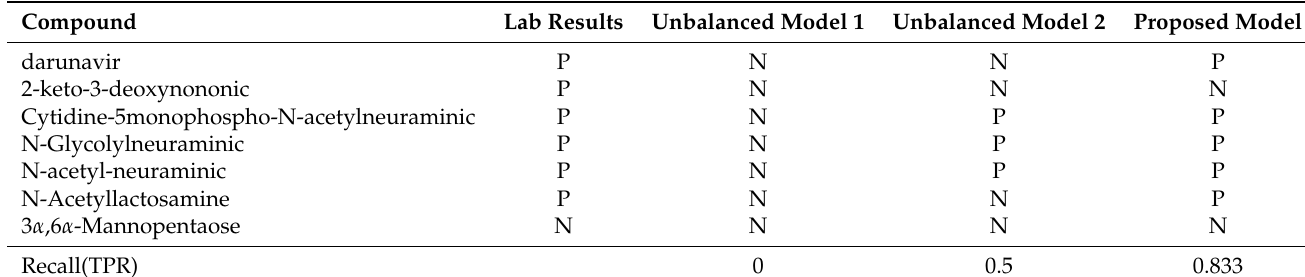
Table 6. Comparison of the two unbalanced models and our proposed method on in-lab experimen- tal